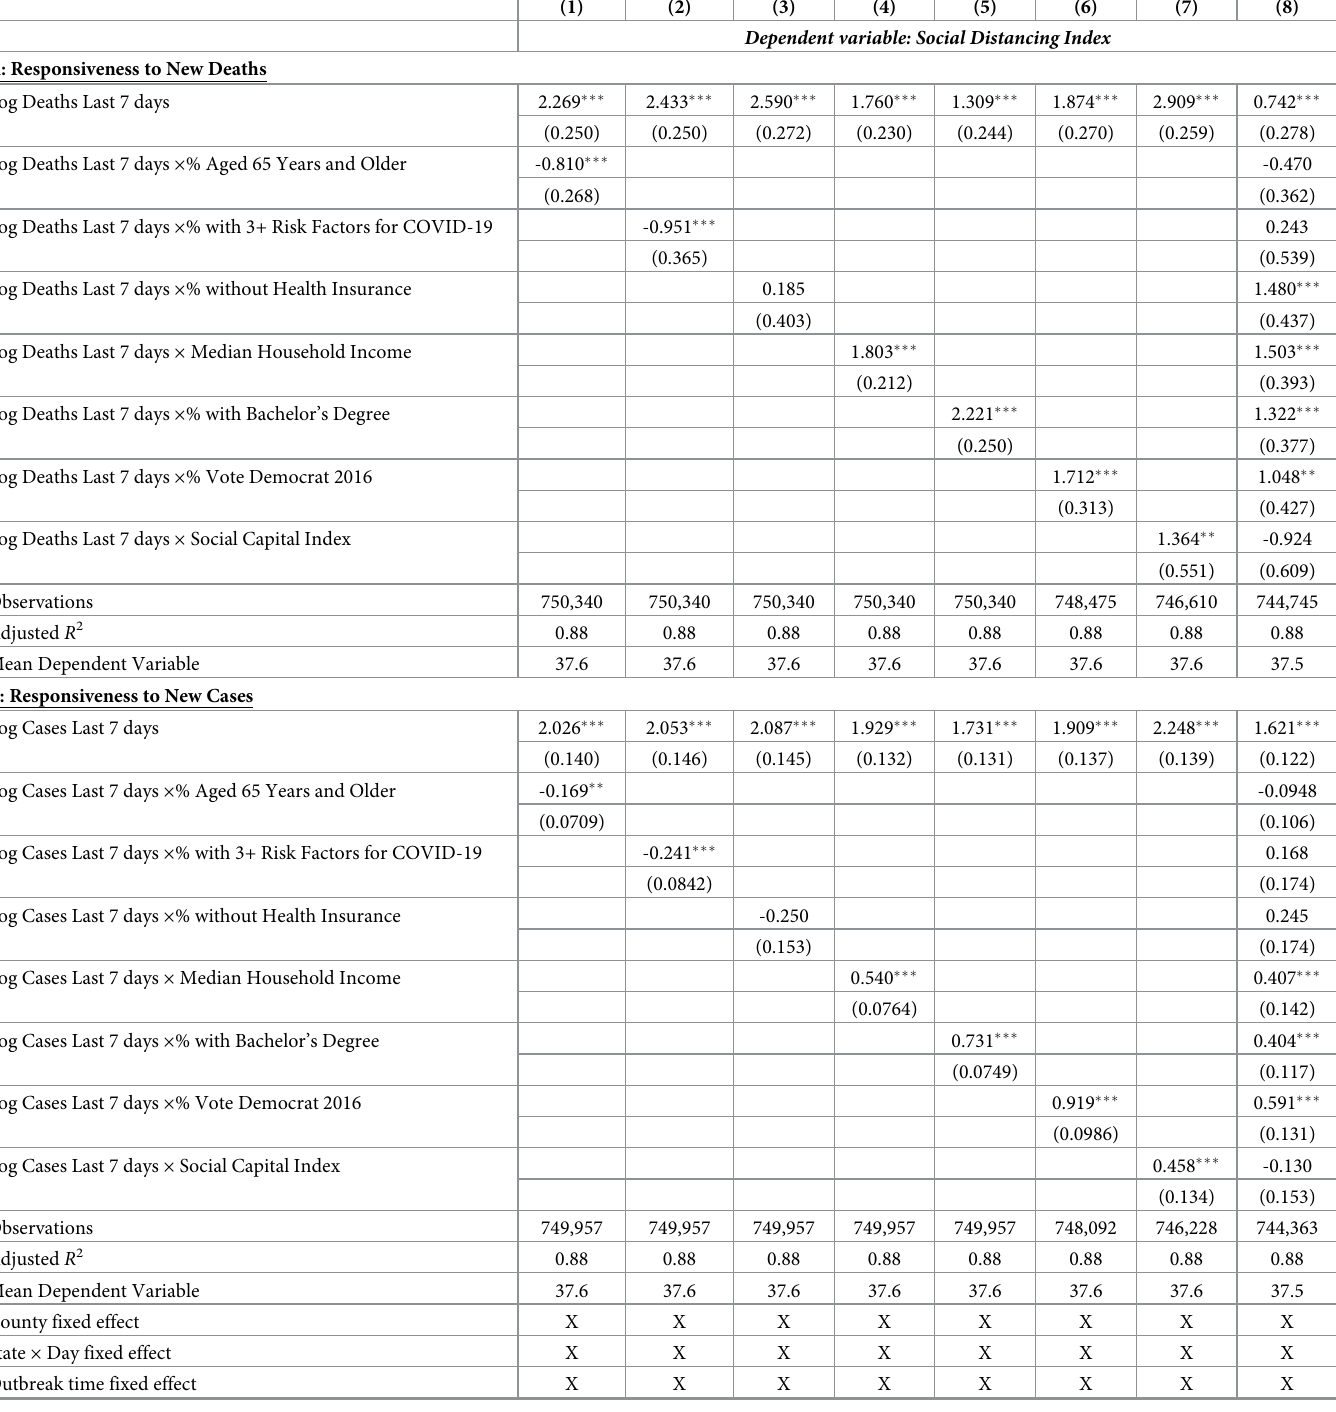
Table 3. Determinants of responsiveness to COVID-19